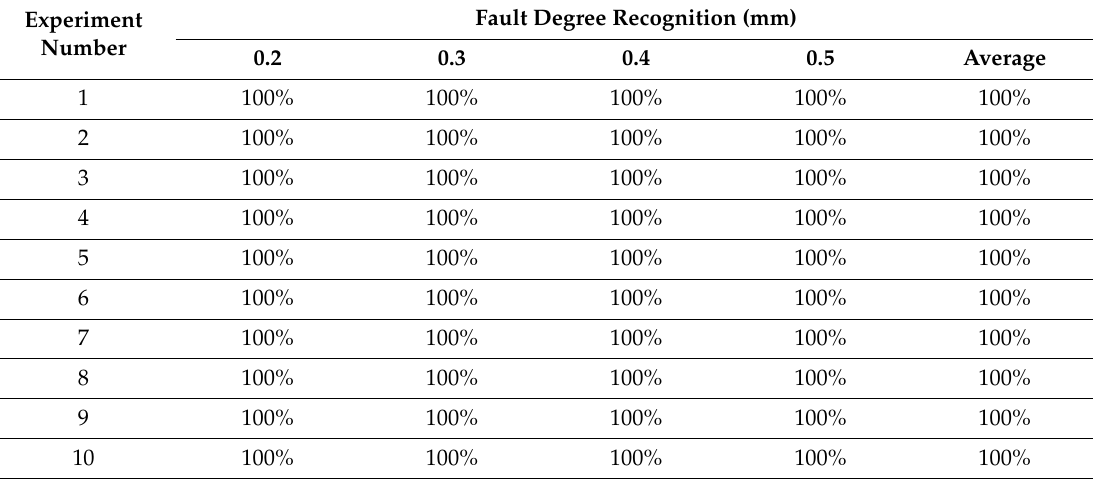
Table 5. Testing results of outer fault degree recognition by hierarchical fault diagnosis model.